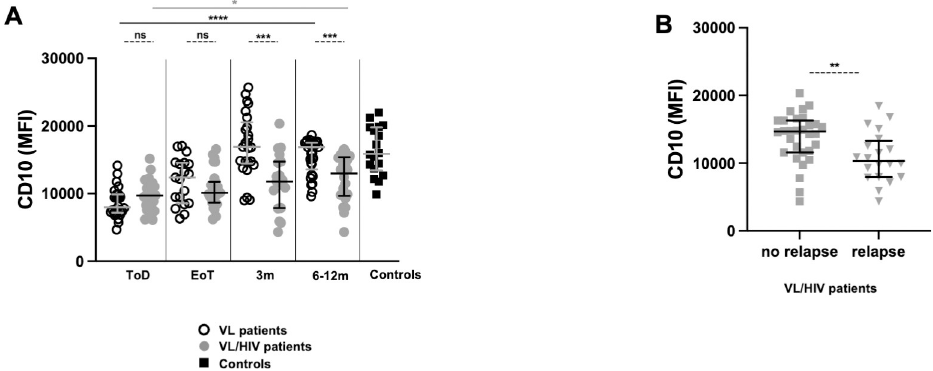
Fig 3. Comparison of neutrophil CD10 expression levels between VL and VL/HIV patients and controls over time. Neutrophils were isolated from whole blood by dextran sedimentation and the expression levels (MFI = Median Fluorescence Intensity) of CD10 were measured by flow cytometry on neutrophils from controls (n = 18), VL (ToD: n = 26, EoT: n = 19, 3m: n = 25, 6-12m: n = 29) and VL/HIV (ToD: n = 27, EoT: n = 26, 3m: n = 19, 6-12m: n = 22) patients as described in Materials and Methods. A. Comparison of CD10 MFI on neutrophils from VL, VL/HIV and controls patients over time. B . Comparison of CD10 MFI on neutrophils from VL/HIV patients who did not relapse (n = 30) and those who relapsed (n = 20) after successful anti-leishmanial treatment, during the 3m and 6–12 follow- up period. If a patient did not relapse during the two-time points of follow-up and if a patient relapsed at both 3 and 6–12 months, this is represented as 2 measurements. Each symbol represents the value for one individual. Results are presented as median with interquartile range. Statistical differences between VL and VL/HIV patients at each time point or between VL/HIV patients who did not relapse and those who relapsed were determined using a Mann- Whitney test and statistical differences between the 4 different time points for each cohort of patients were determined by Kruskal-Wallis test. ToD = Time of Diagnosis; EoT = End of Treatment; 3m = 3 months post EoT; 6-12m = 6–12 months post EoT. ns = not